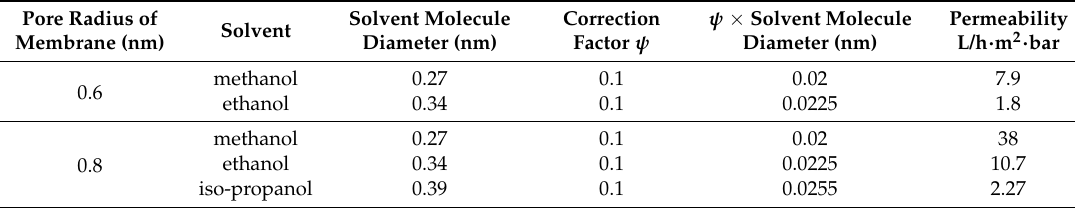
Table 3. Solvent permeability through the ceramic Si–Zr membrane reported by [40]. Pore Radius of Membrane